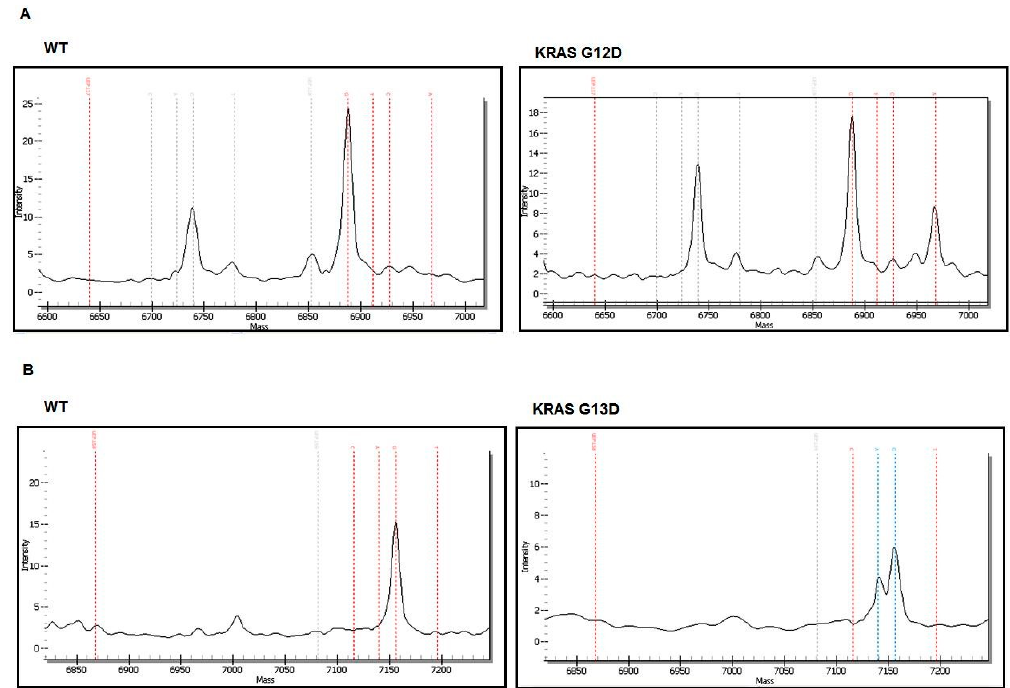
Figure 4. Spectrum of the Sequenom assay shows KRAS mutations. ( A ) G12D KRAS mutation (exon 2 codon 12), ( B ) G13D KRAS mutation (exon 2 codon 13).